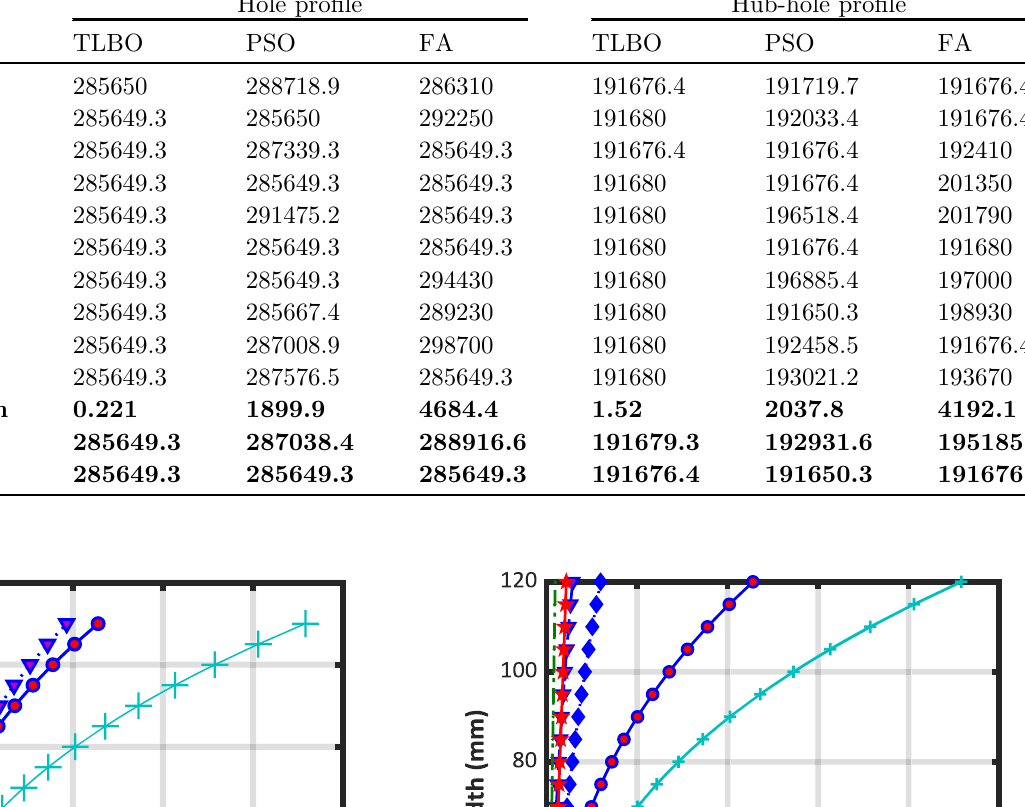
Table 4. Volume (mm 3 ) experimentation results for hole-pro fi le and hub-hole-pro fi le. Experiment No.